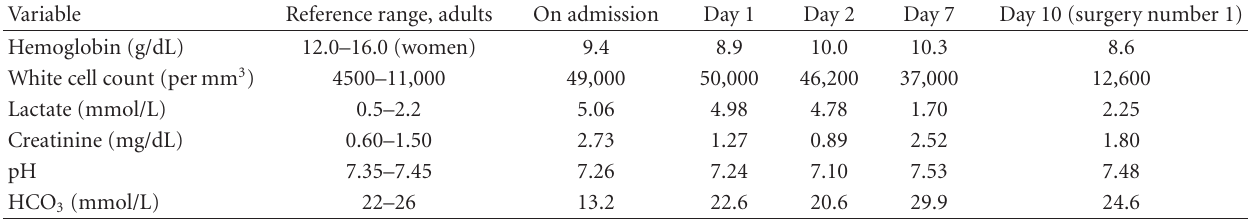
Table 1: Laboratory data.